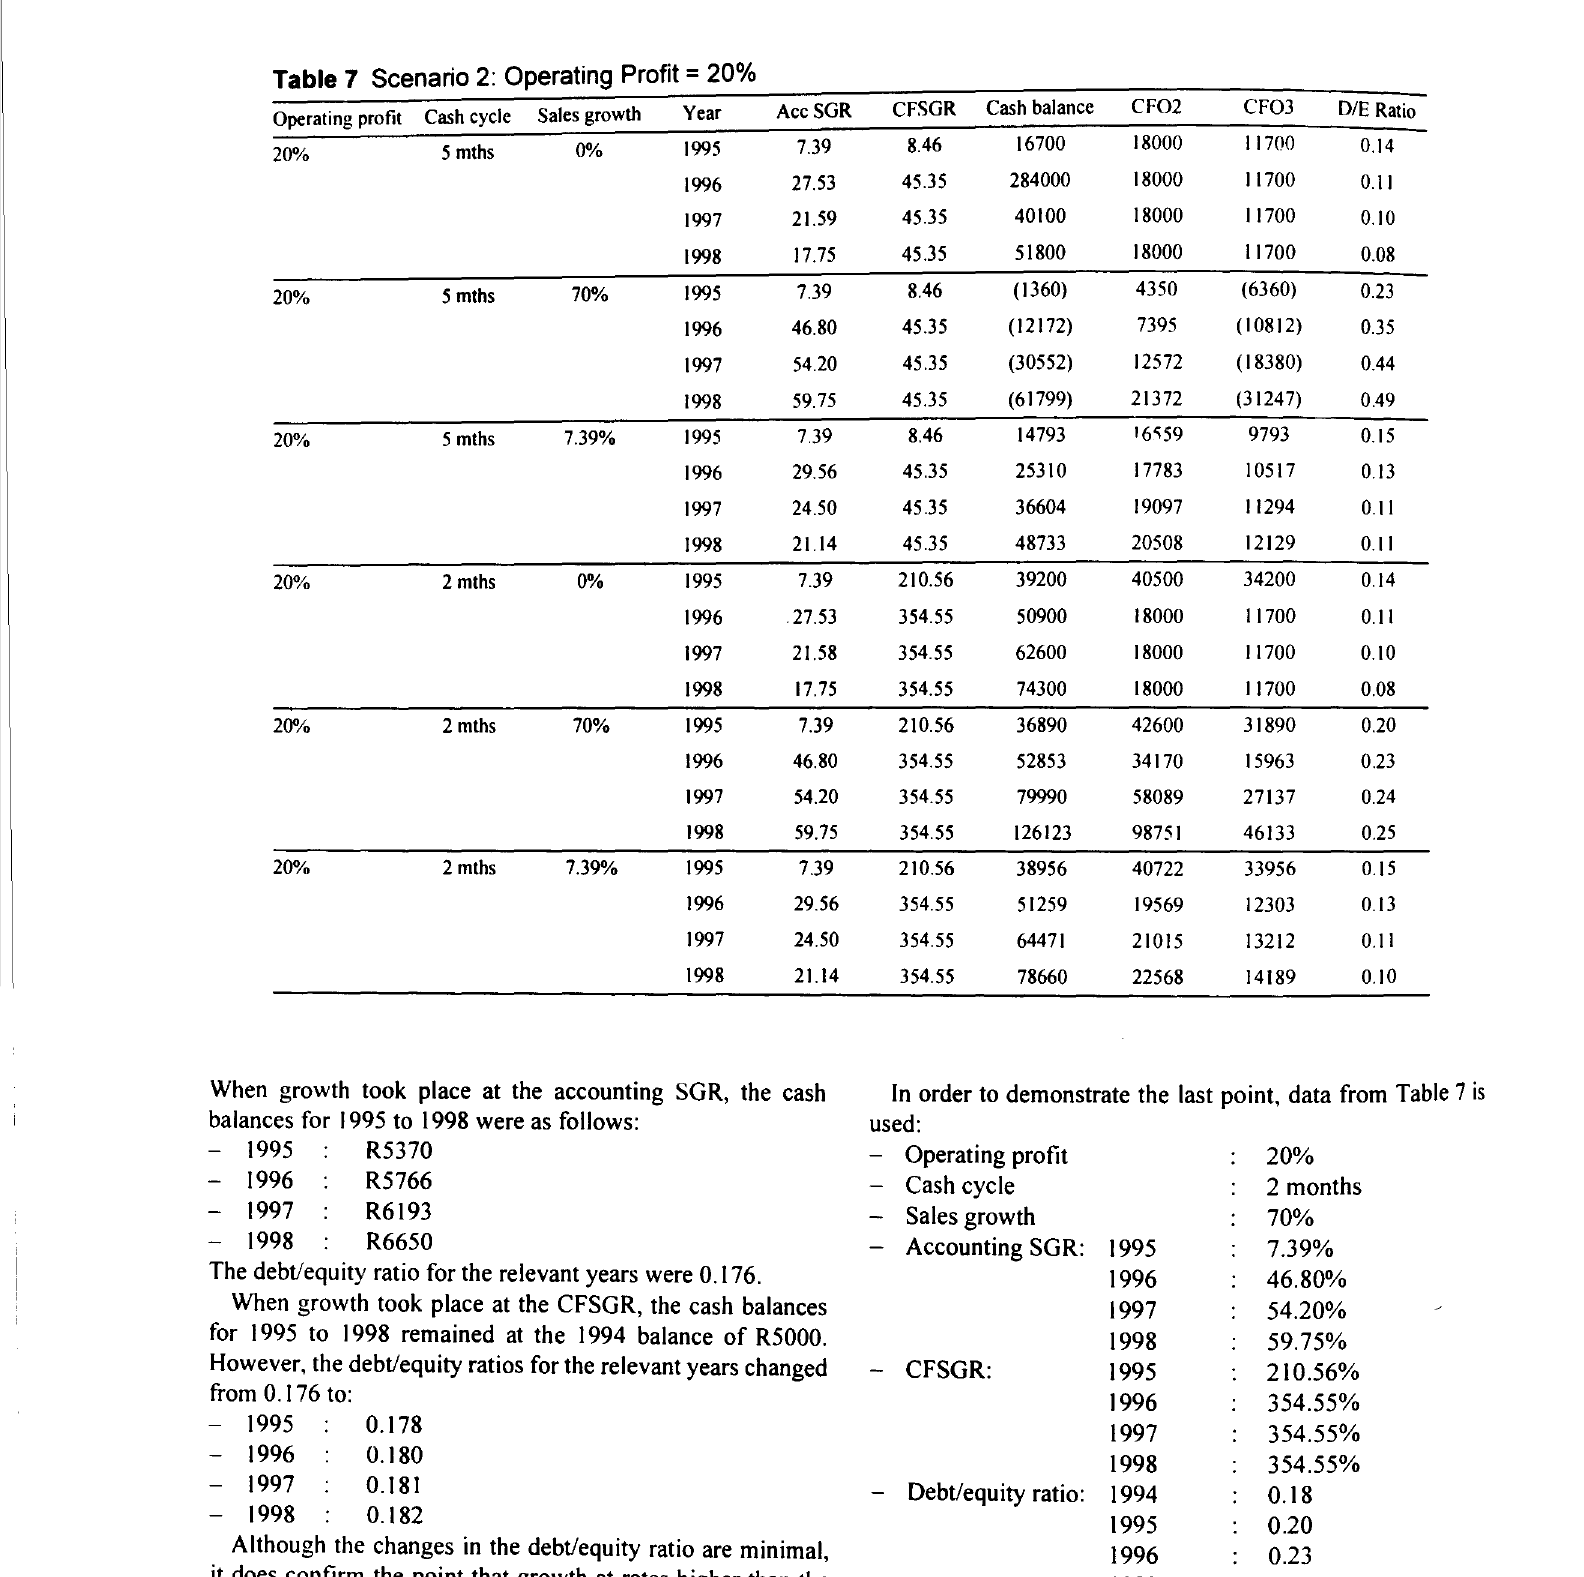
Table 7 Scenario 2: Operating Profit =